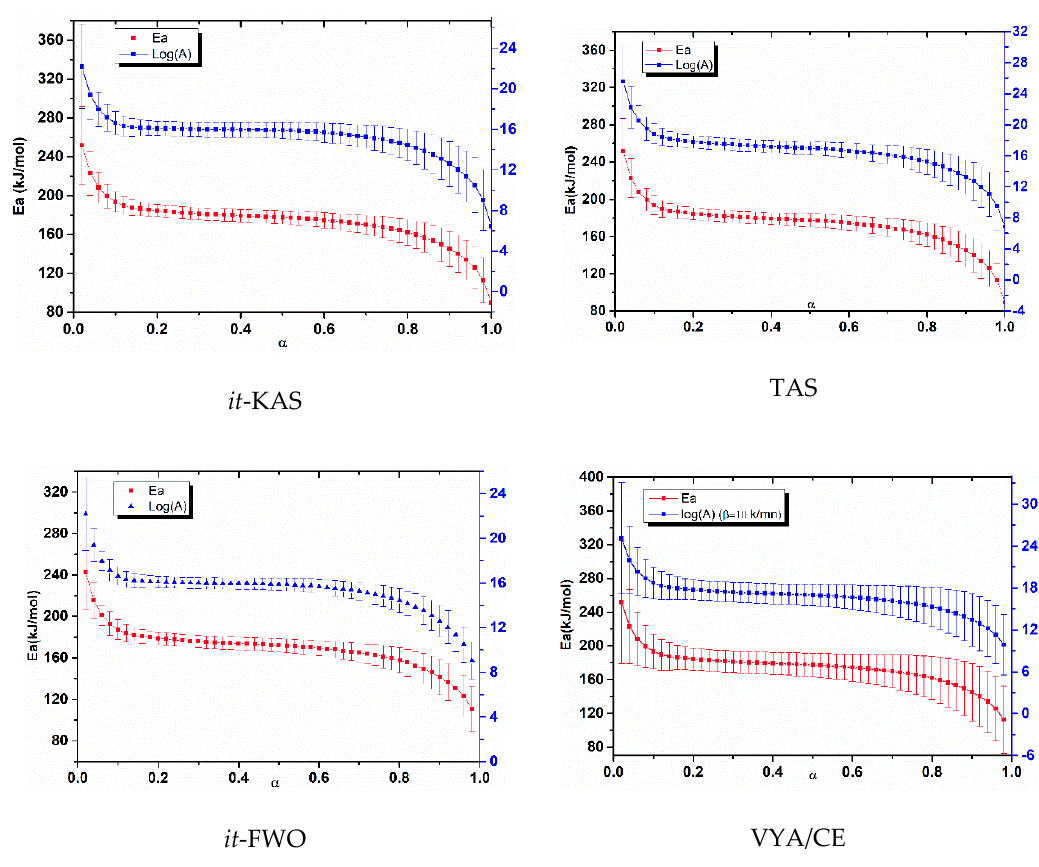
Figure 6. Arrhenius parameters and their associated confidence intervals evolution with respect to α determined by the different kinetic methods for pure NC.